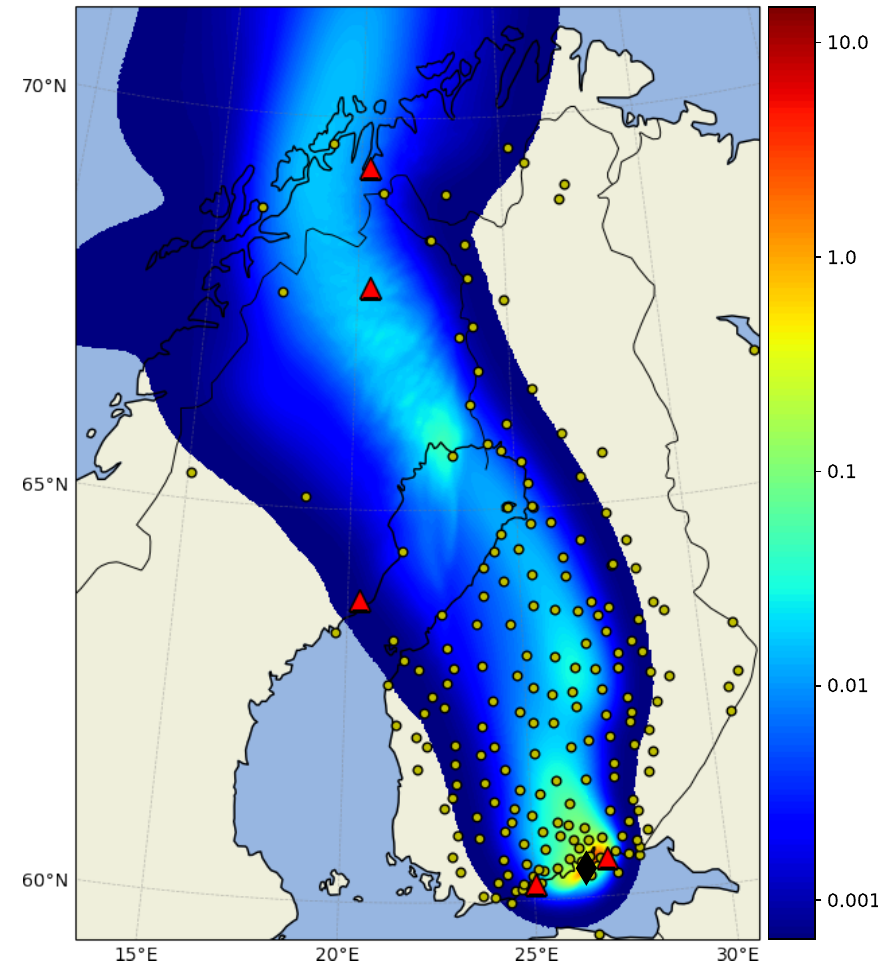
Figure 1. Total gamma dose in units of mSv at 63 h after the release start. Areas only influenced by background radiation are left uncolored. The black diamond shows the release location, the yellow circles show the locations of the gamma stations, and the red triangles show the locations of the filter